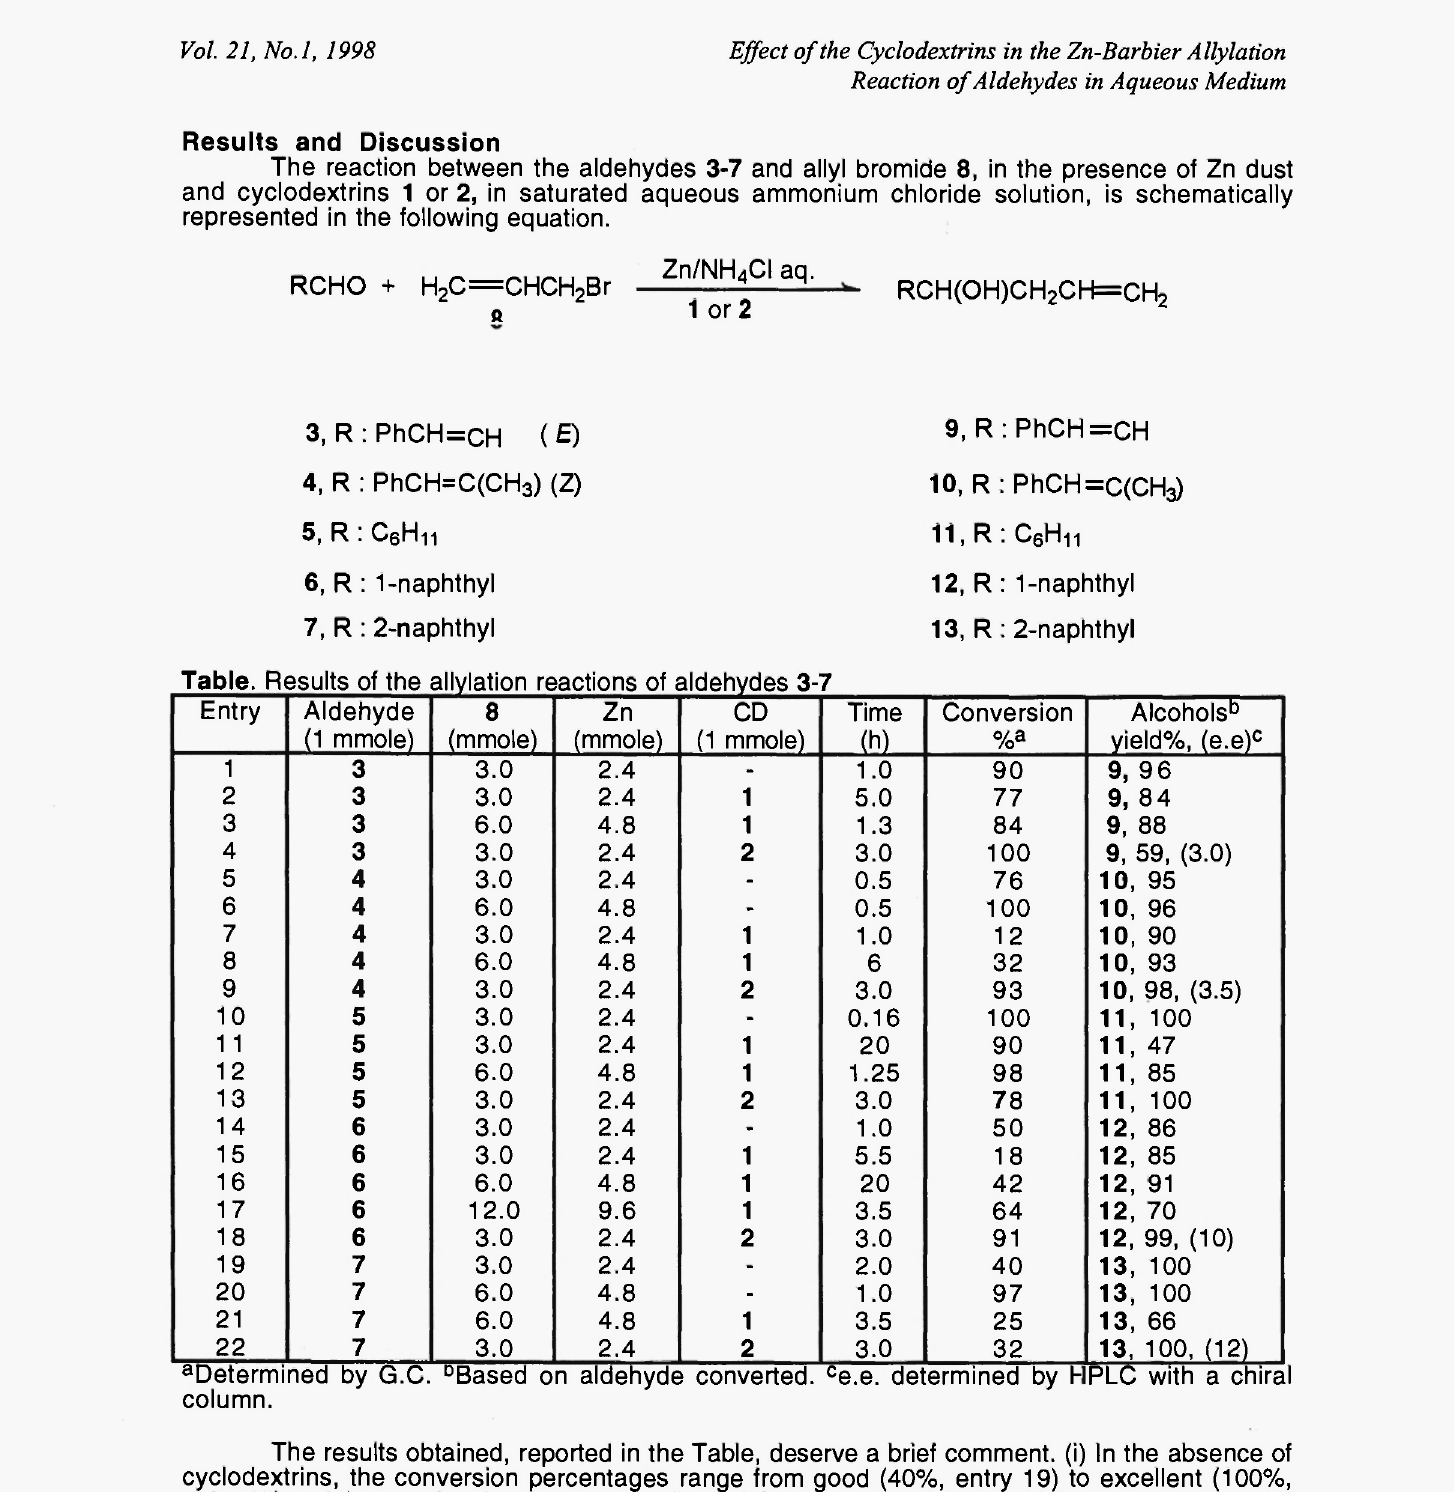
Table. Results of the allylation reactions of aldehydes